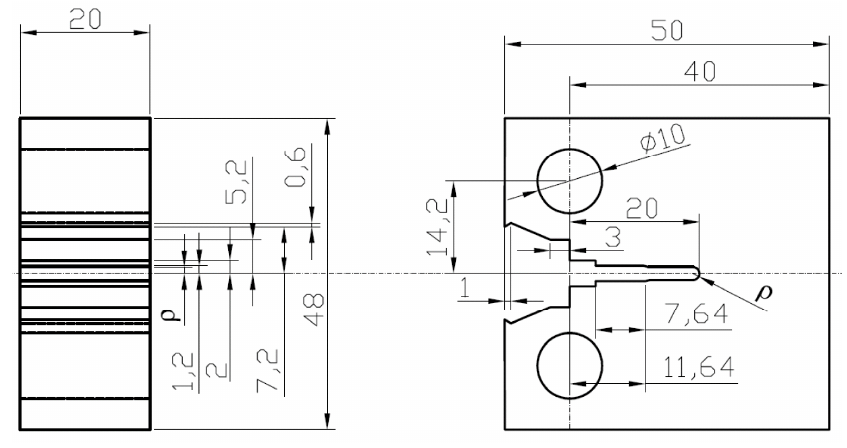
Figure 5. Geometry of compact tension (CT) specimens [3], dimensions in mm.